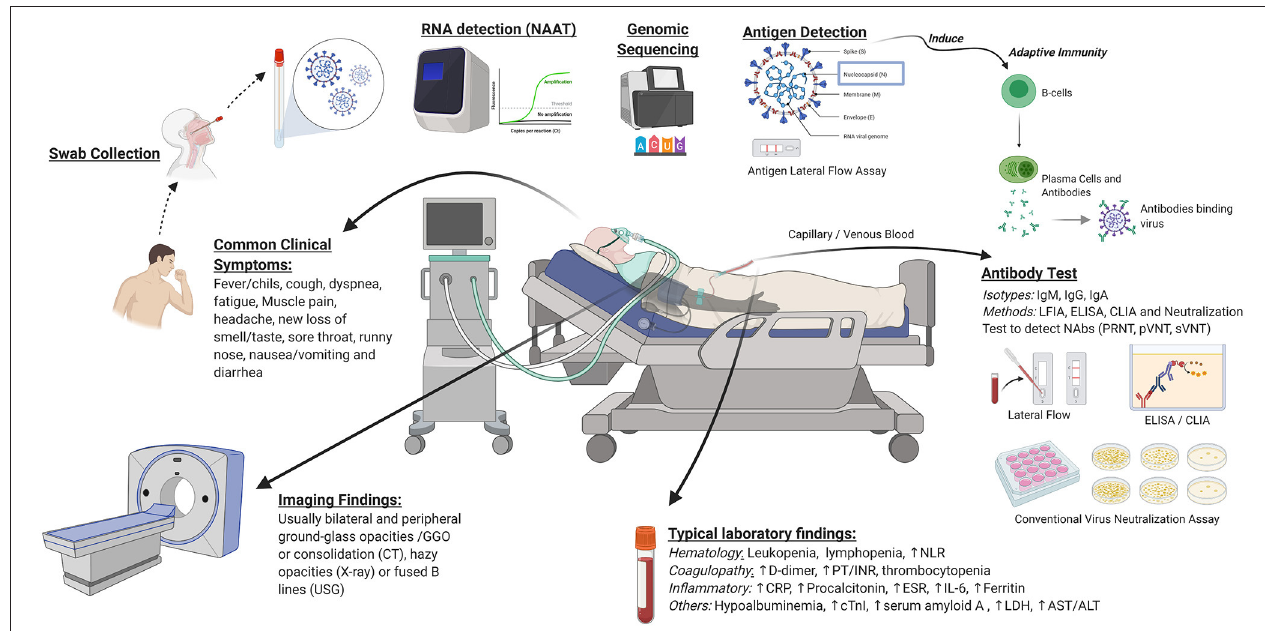
FIGURE 2 | Clinical and in vitro diagnostics for COVID-19. Clinical diagnostics consist of common clinical symptoms, imaging findings, and laboratory markers. In vitro diagnostics include molecular testing, antibody tests, and viral antigen detection. NAAT, nucleic acid amplification tests; PoC, point of care; CRISPR, clustered regularly interspaced short palindromic repeats; NAbs, neutralizing antibodies; PRNT, plaque reduction neutralization test; pVNT, pseudovirus-based virus neutralization test; sVNT, surrogate virus neutralization test; LFIA, lateral flow immunoassay; ELISA, enzyme-linked immunosorbent assay; CLIA, chemiluminescent immunoassay; NLR, neutrophil-lymphocyte ratio; PT/INR, prothrombin time and international normalized ratio; CRP, C-reactive protein; ESR, erythrocyte sedimentation rate; IL-6, interleukin 6; cTnI, cardiac troponin I; LDH, lactate dehydrogenase; AST, aspartate aminotransferase; ALT, alanine aminotransferase; CT, computed tomography; USG, ultrasound sonography. Image was created in